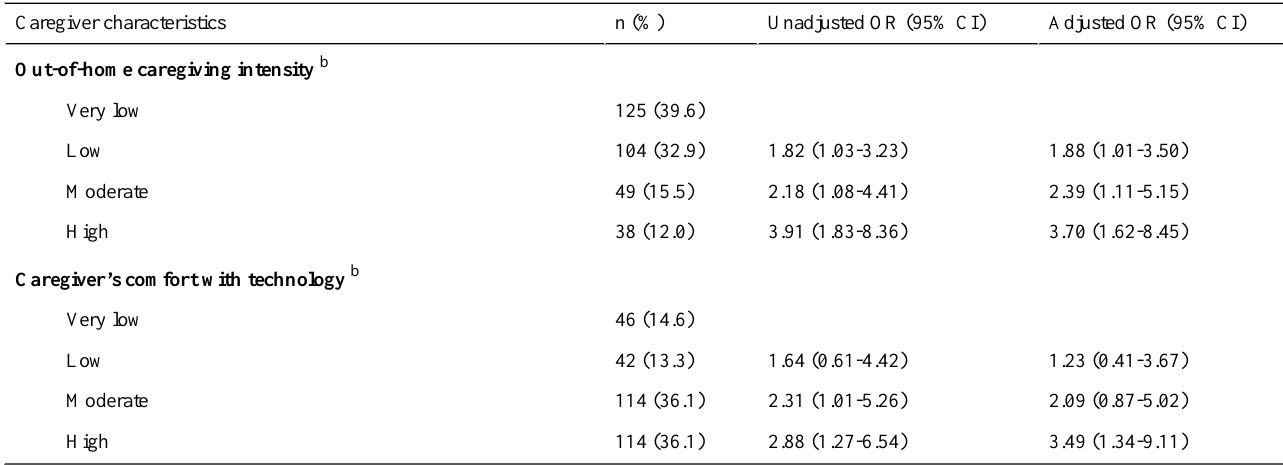
Table 3. Out-of-home caregivers’ characteristics associated with their use of health information technology to support individuals with chronic conditions a (N=316; 301 of whom are in multivariate model).